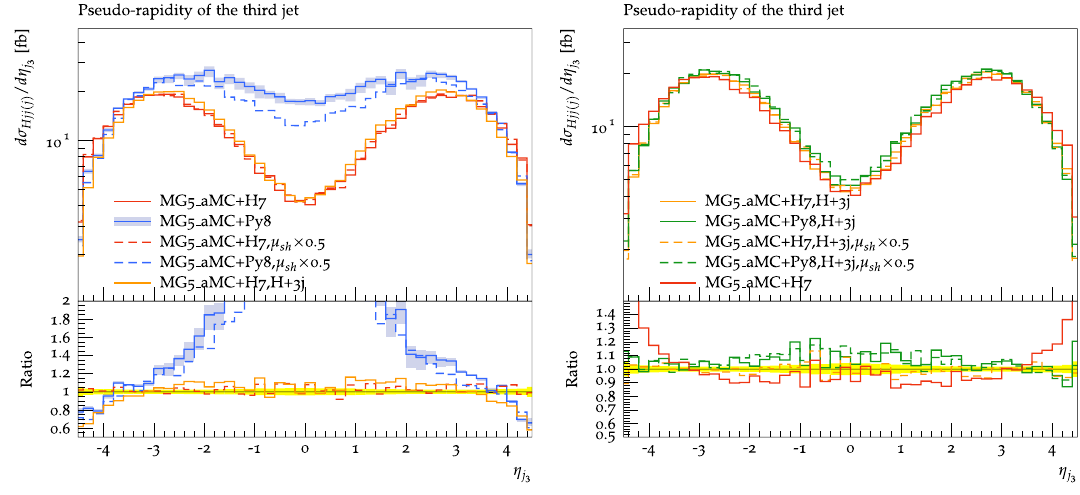
Fig. 5 Same as in Fig. 4, for the rapidity of the third